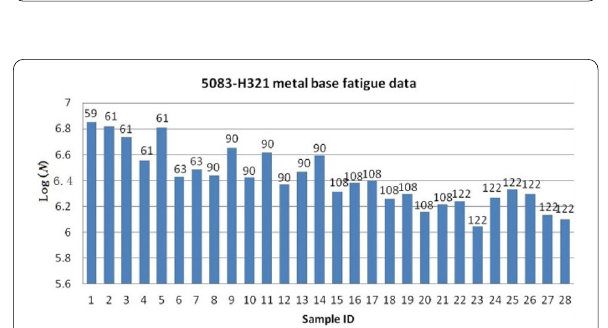
Figure 8 5083-H321 metal base fatigue